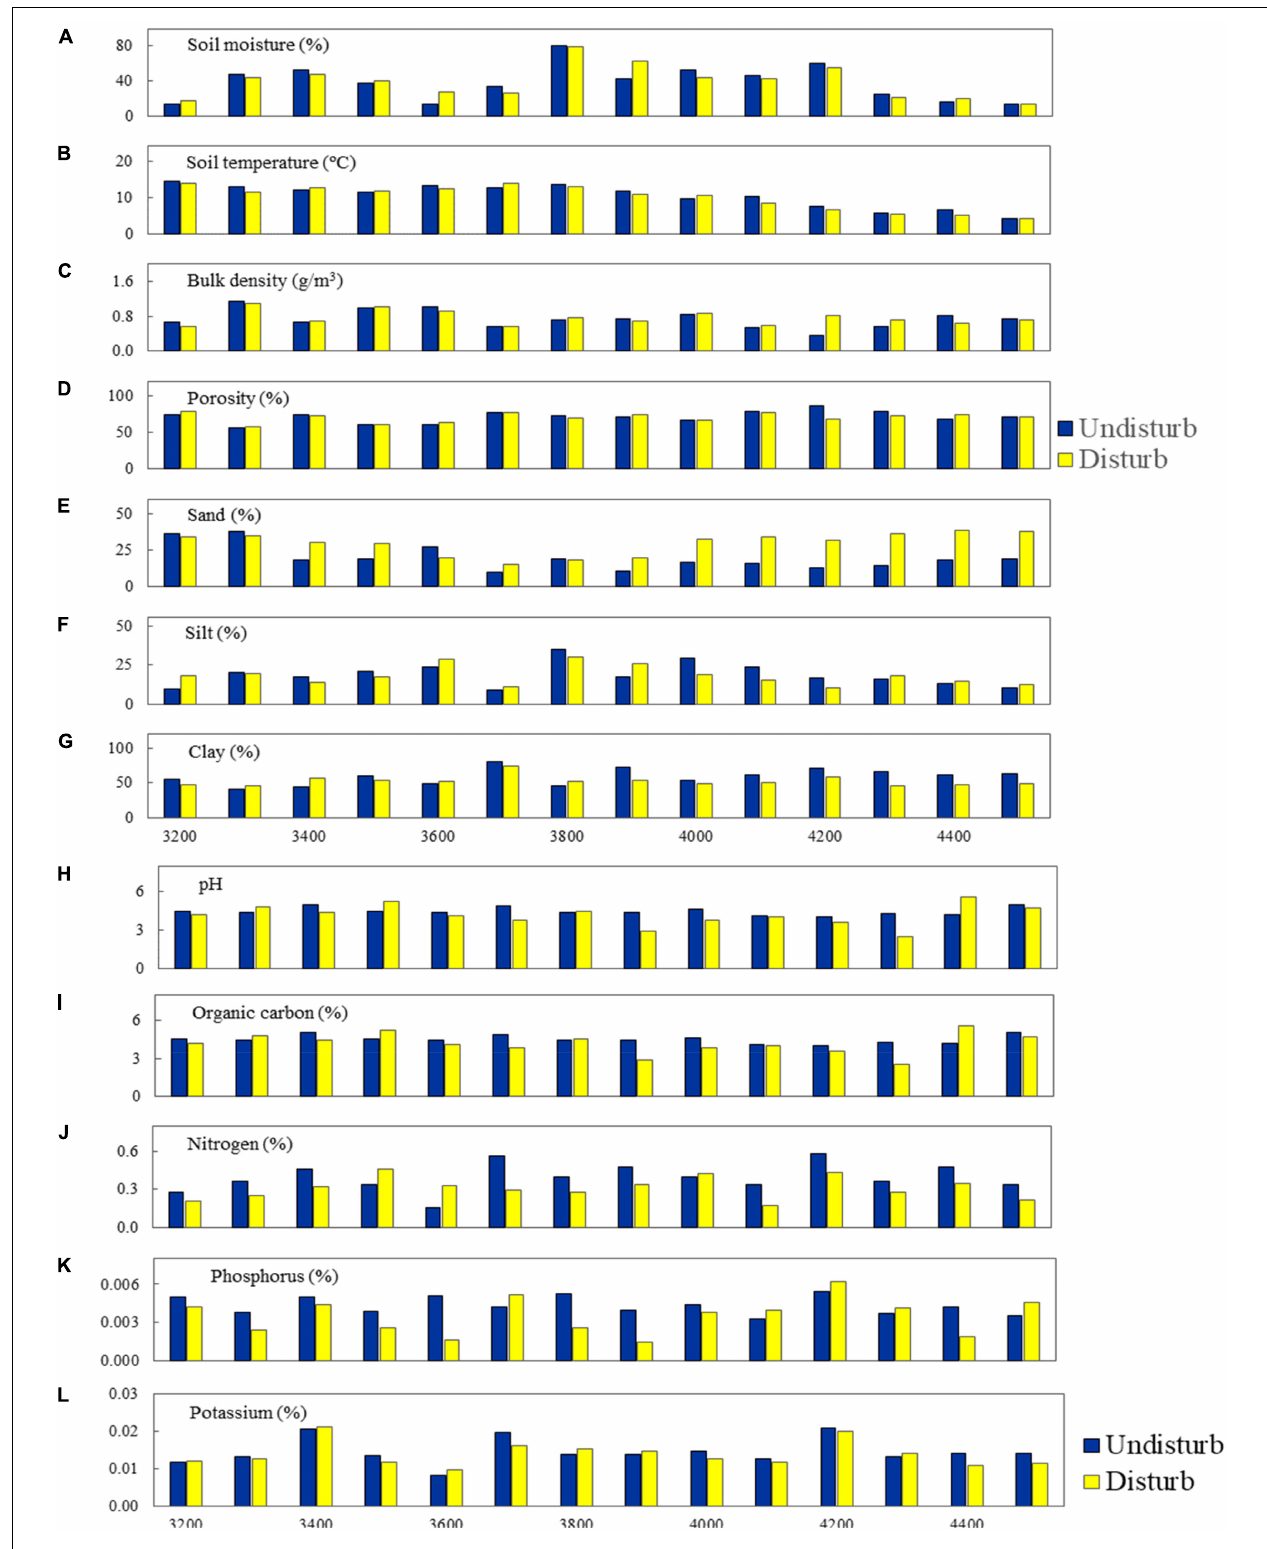
FIGURE 8 | Physicochemical properties of soil for undisturbed and disturbed sites in GHNP.